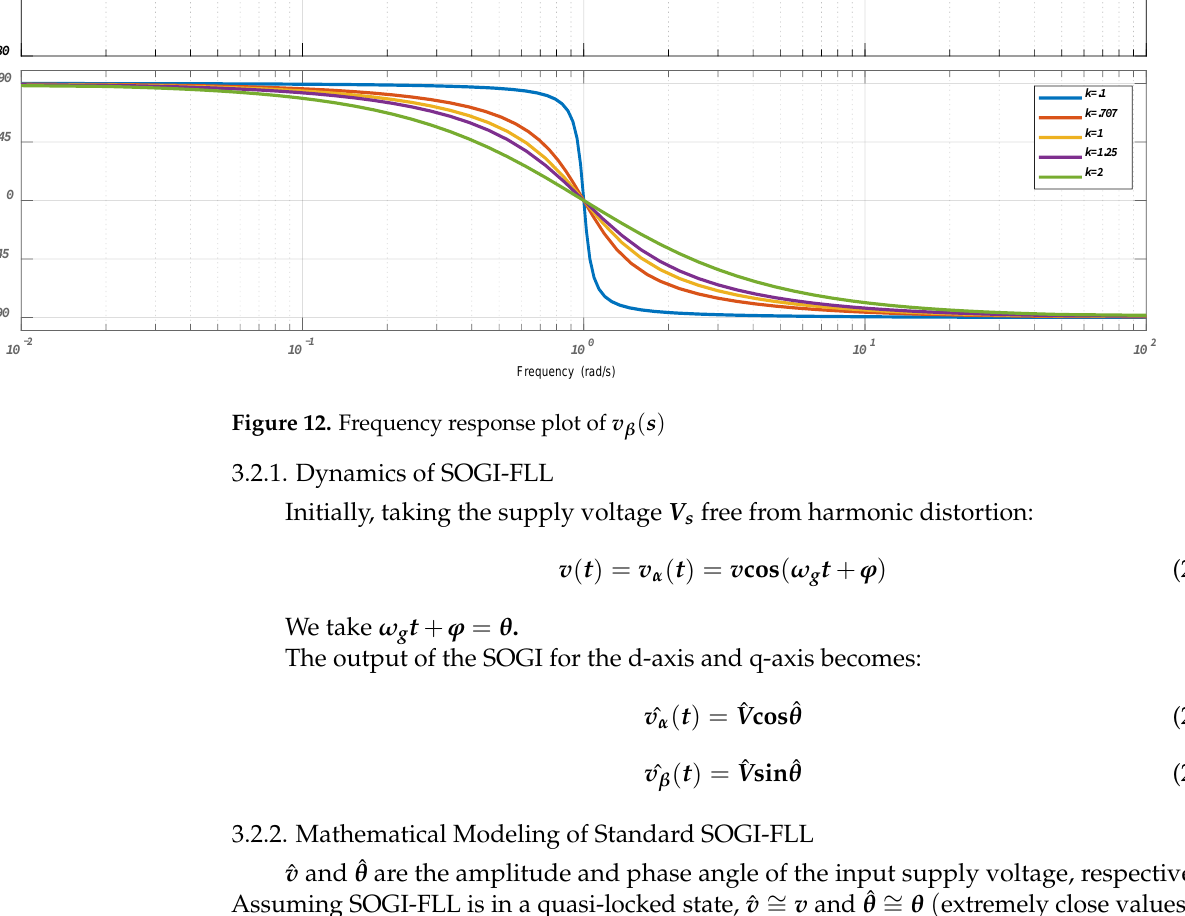
Figure 11. Frequency response plot of